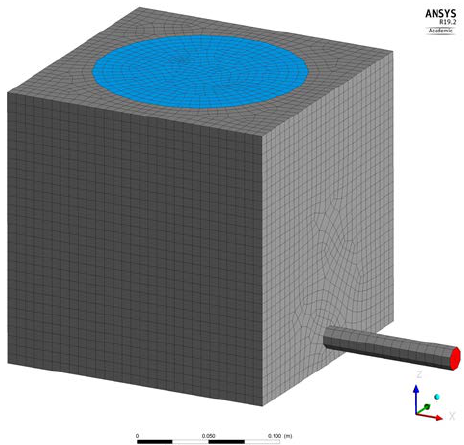
Figure 3. Geometry and mesh of the CFD model for CFD–DEM simulation. Inlet (blue) on the top and tapping hole (red) on the right side. Table 1. Values of the slag and matte parameters.